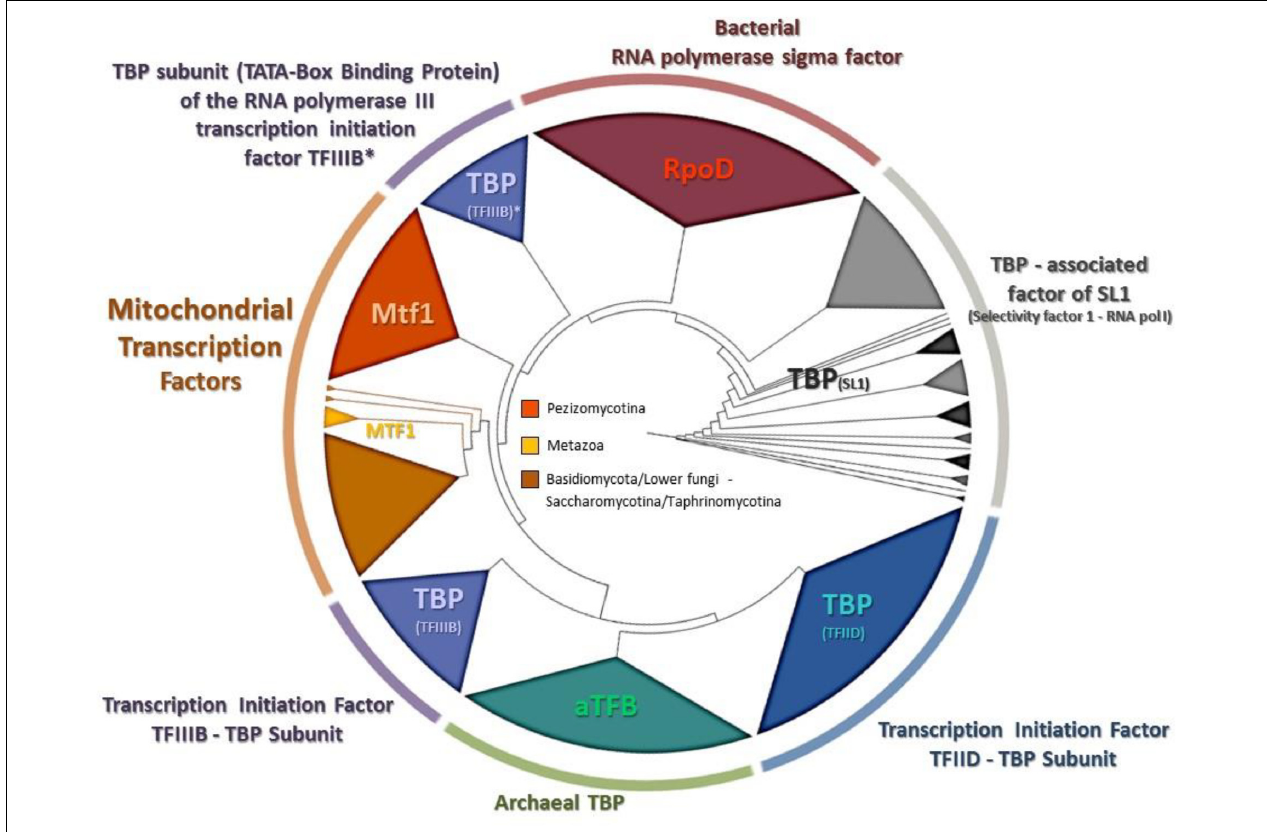
FIGURE 7 | The phylogenetic tree produced for MTF1 and all homologous transcription factors from representatives of all living domains, using NJ and RaxML methods. RAxML-bootstrap support was in all topologies above 95% and it is not shown. Gene clusters of organisms belonging to the same taxonomic division are shown in different